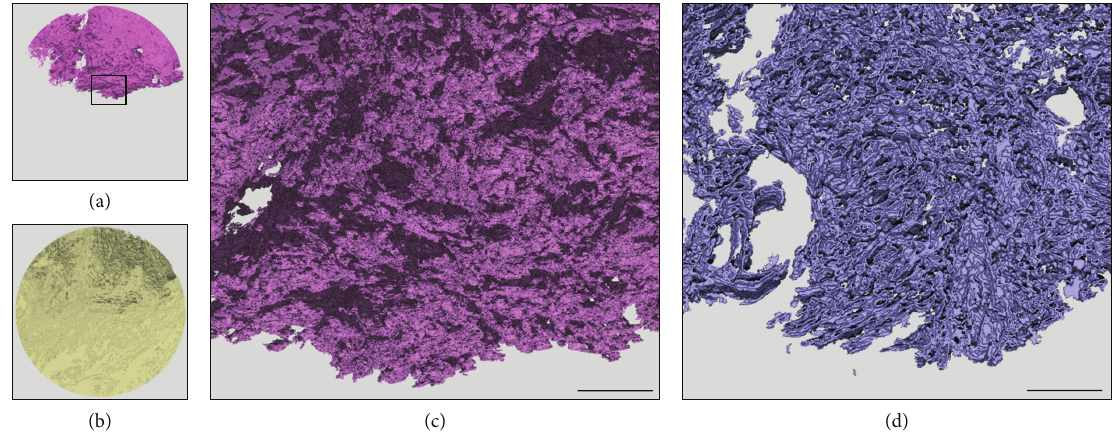
Figure 3: (a, b) 3D view of the segmented tumor parenchymal (purple) and stromal (yellow) regions, respectively. (c) Enlargement of the CK-positive tumor architecture in the rectangle shown in (a), showing in detail the interconnected tumor texture and channels or holes corresponding to penetrating stromal strands. (d) Labyrinthine architecture of the tumor parenchymal-stromal border, which was virtually displayed in a plane of one voxel in width. Note that this 3D image was constructed using 30 serial sections to improve the visibility of the tortuous architecture. Bar = 0.5